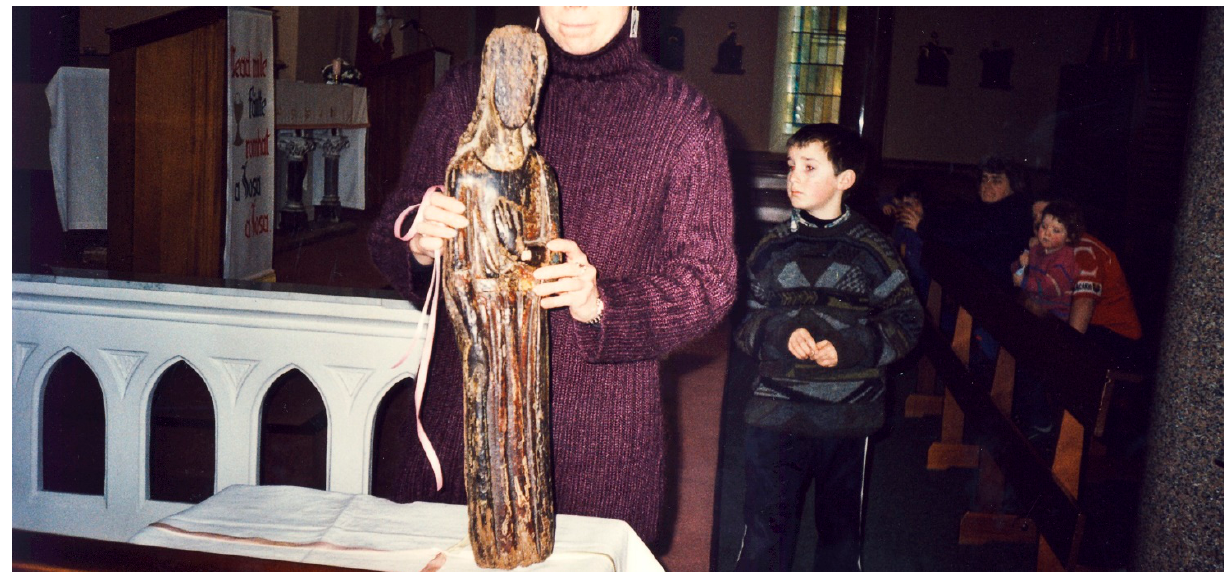
Figure 14. A wooden statue believed to be the image of St. Gobnait, Ballyvourney. Over a window of the ruined church in Ballyvourney is carved a little image of a nude female which belongs to a group called sheela-na-gigs –fertility figures (Figure 15). However, in Ballyvourney by some pilgrims called it St. Gobnait 44 (Guest 1937, p. 375; cf. Harbison 1991, p. 134). Pilgrims rub it with their hands or touch with handkerchiefs and “then passing into the church by the window, the handkerchief is made with appropriate gestures to touch the votary” (Guest 1937, p. 375). Sheela-na-gig by the well at Castlewidenham (Co. Cork) was touched “for help in childbirth” (Guest 1937, p. 380). In Ballyvourney, deep in the cavity of the wall of Gobnait’s Church with sheela is placed Saint Gobnait’s Bowl ( Bulla ). It is of agate, described by John O’Hanlon (1875?, p. 468) as “a round bowl of dark-coloured stone, polished and smooth as ivory”. The pilgrim touches it three times. Each time s/he crosses her/himself with the hand it touched the bowl in order to transfer its virtues. According to Edith M. Guest (1937, p. 376), it “has been efficacious for the cure of contusions”.